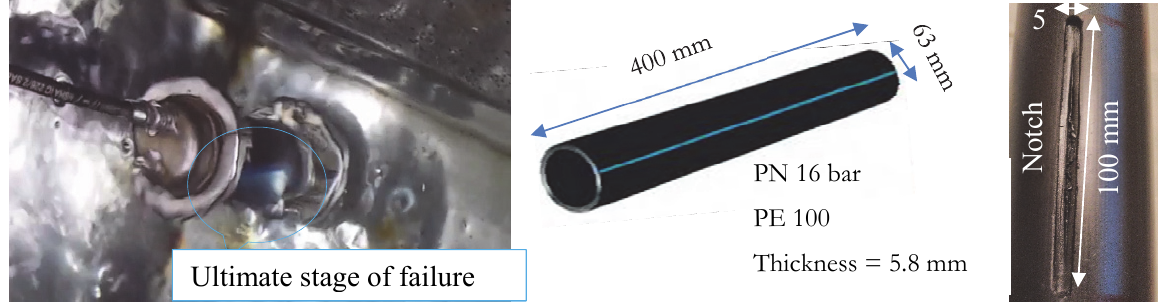
Figure 1: Bursting of HDPE pipes and the specimen and notch